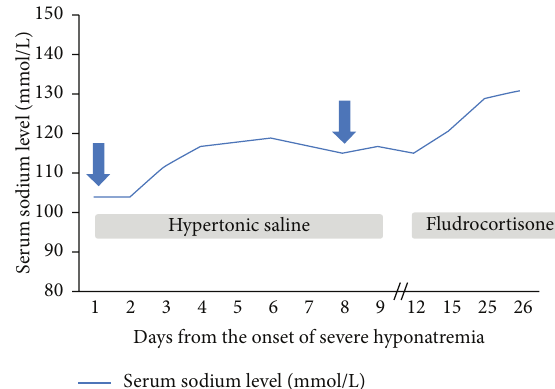
Figure 1: Changes in serum sodium levels during the treatment of hyponatremia in a patient with extensive stage SCLC. The figure illustrates changes in serum sodium levels in relation to the received treatment (hypertonic saline or fludrocortisone). The blue arrows indicate the onset of neurological symptoms. The first and relatively severe neurological symptoms (disorientation, mental confusedness) appeared 2 days after the completion of the first cycle of second-line chemotherapy with topotecan. Secondary, a slighter and less durable disorientation appeared during the treatment with hypertonic saline. Hypertonic saline treatment was given on days 1– 9aftertheonsetofseverehyponatremiaandfludrocortisonestarting from day 12. In between (on days 10 and 11), patient received no treatment since the acquisition of the fludrocortisone from hospital pharmacy took 2 days. Quick increase of the serum sodium level into the steady normal range was achieved only with fludrocortisone 0.1 mg